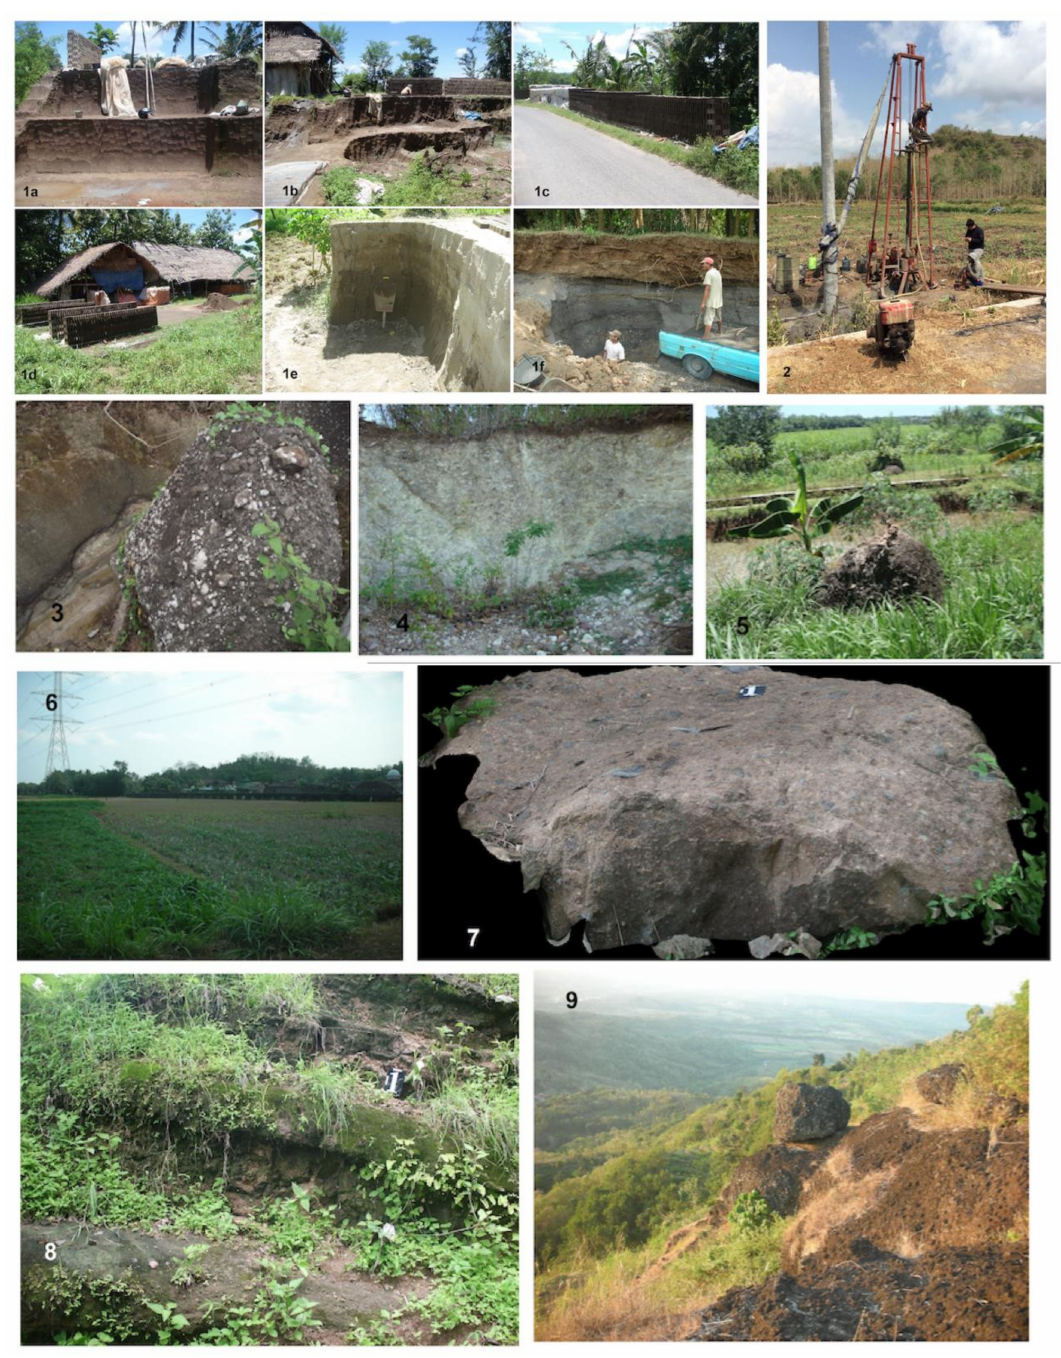
Figure 11. Documentation of lithological observation in the field (the numbers of the picture refer to the improved geological map Figure 11 Top left